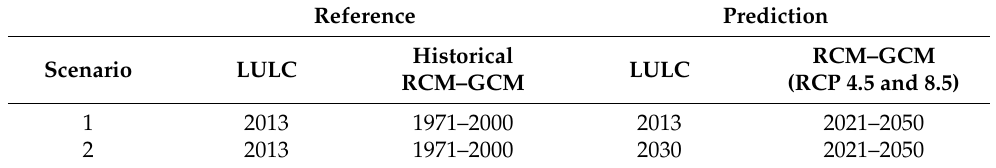
Table 2. Model setup for the hydrological impact assessment of climate and land